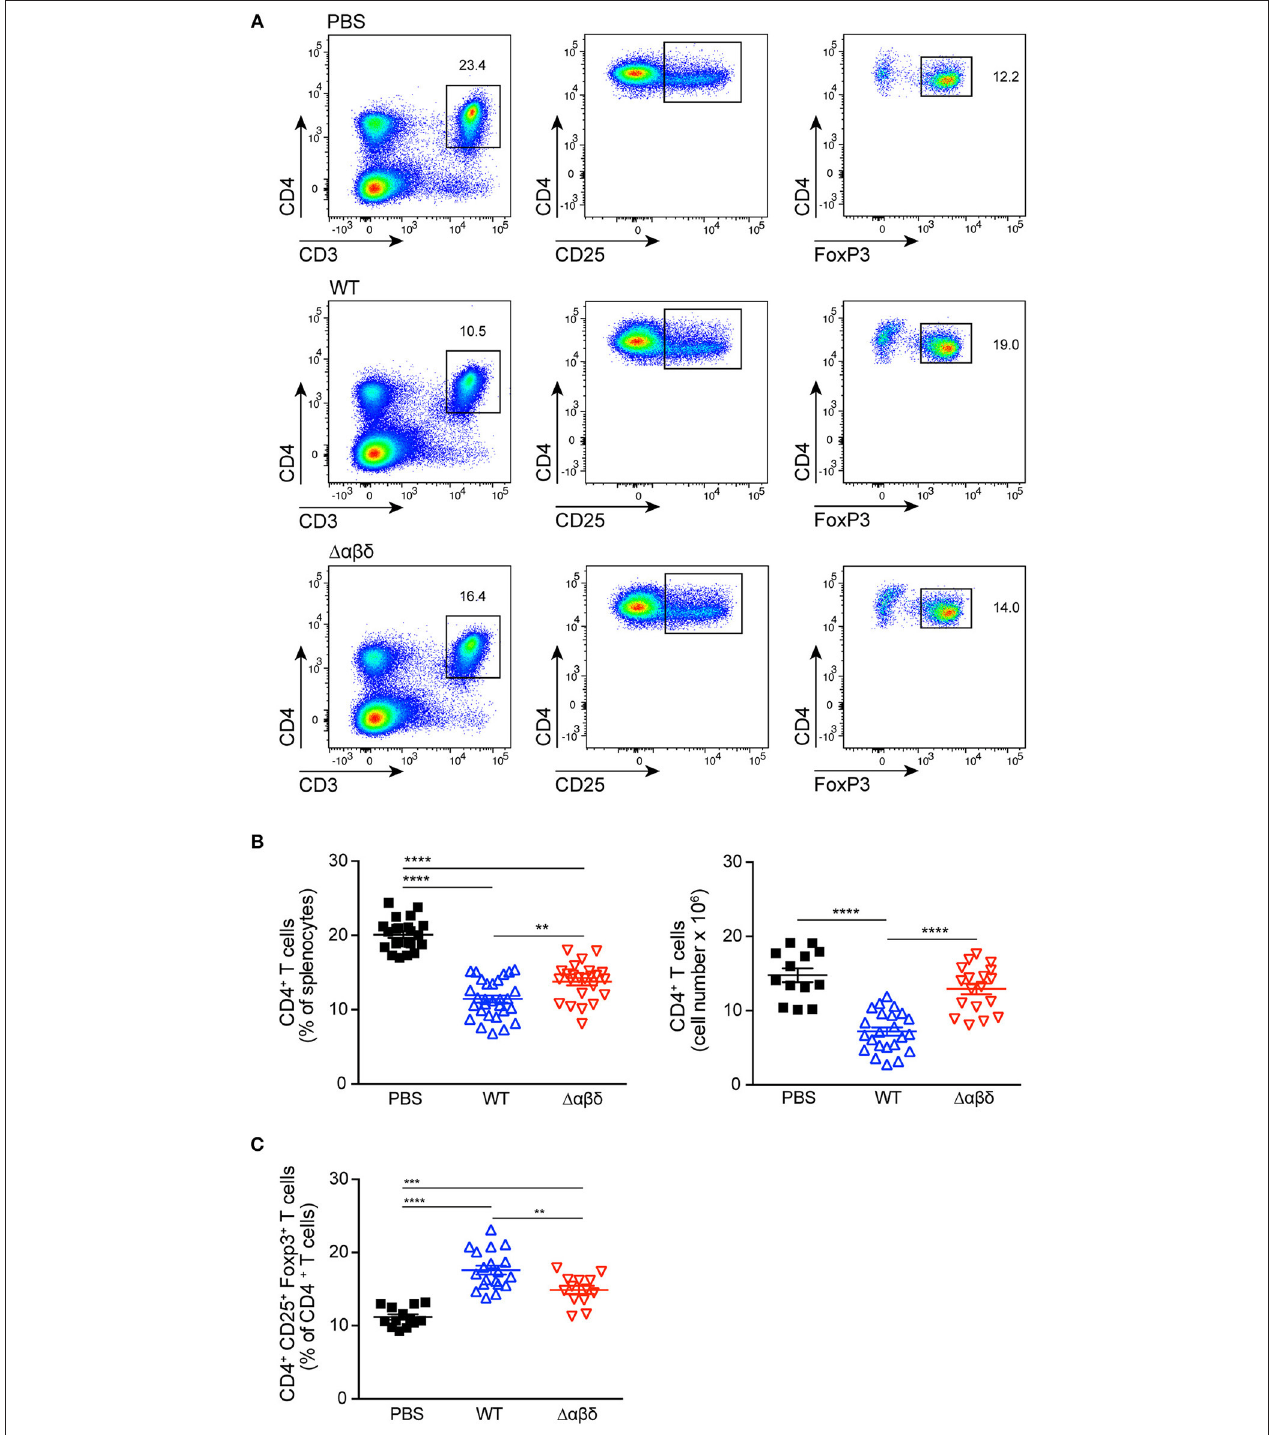
FIGURE 4 | PSMs modulate CD4 + T cell responses. Foxp3-eGFP mice were either treated with PBS or infected with S. aureus USA300 WT or the PSM-deficient S. aureus USA300 1 αβδ mutant strain for 3 days and splenocytes were analyzed for CD4 + T cells by flow cytometry. (A) Pseudocolor plots show the frequencies of CD4 + and CD4 + CD25 + Foxp3 + T cells in the spleen of PBS-treated or infected mice. Graphical summary of the frequencies and cell numbers per organ of splenic CD4 + T cells (B) and the frequencies CD4 + CD25 + Foxp3 + T cells among CD4 + T cells (C) . Every symbol represents one mouse. The graphs represent the mean ± SEM with data pooled from multiple experiments; quantity of mice and experiments per condition and time is depicted in Table S2 (one-way ANOVA followed by Tukey’s post-hoc test; ** p < 0.01, *** p < 0.001, and **** p < 0.0001).